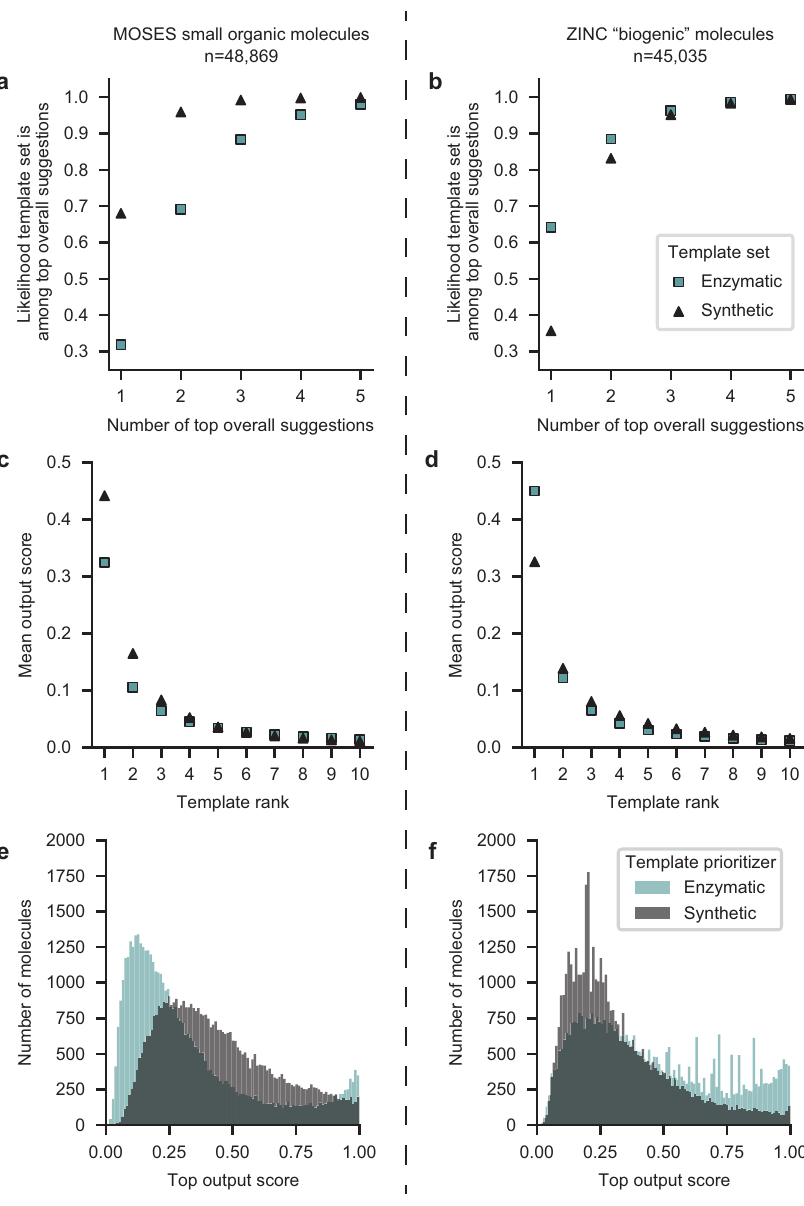
probabilities for a small organic molecules from the MOSES dataset and for b biogenicmoleculesfromZINC.Meansforthetoptenprobabilityscoresusingthe enzymatic (blue square) and organic (black triangle) template prioritizers on c the MOSES subset and on d the ZINC subset. Distribution of top-1 probability scores usingtheenzymatic(blue)andorganic(gray)templateprioritizerswhenthescores are computed for e the MOSES subset and for the f ZINC